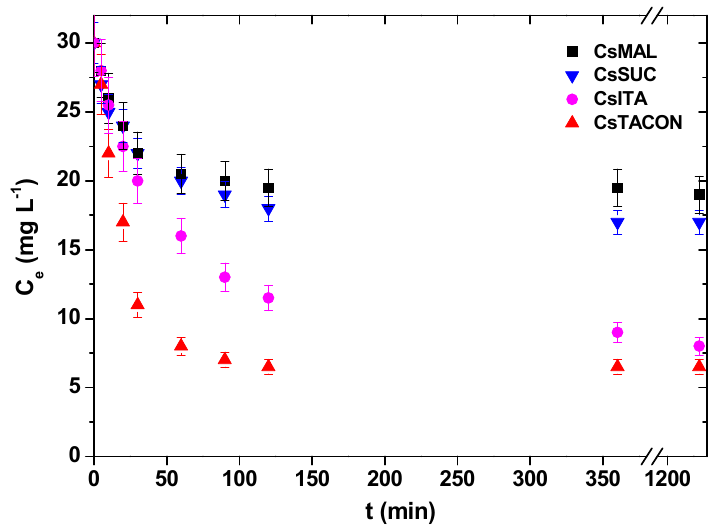
Figure 9. Experimental points (raw data) for the effect of contact time on the removal of DCF by chitosan adsorbents.